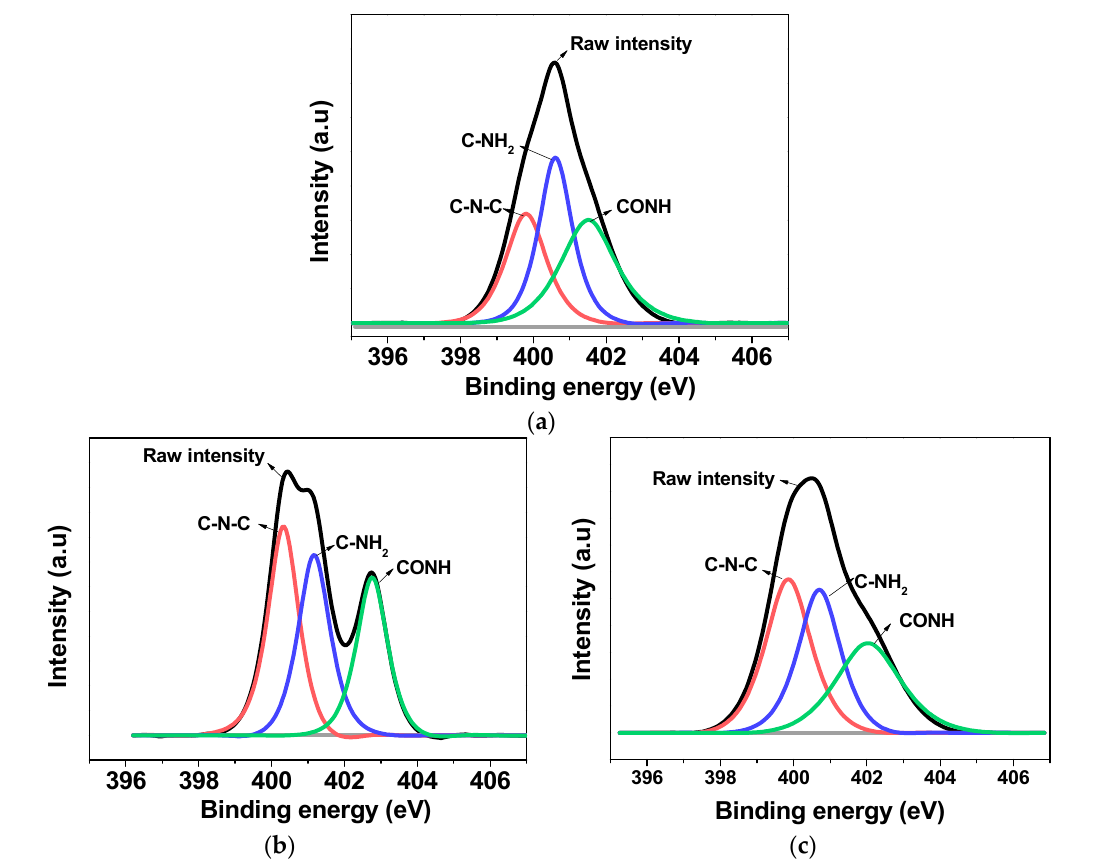
Figure 6. X-ray photoelectron spectroscopy (XPS) N1s curve fitting peak of ( a ) MWCNT-NH 2 , ( b ) MWCNT-BuGE and ( c ) MWCNT-BeGE. Table 1. N1s peak area of MWCNT-NH 2 , MWCNT-BuGE and